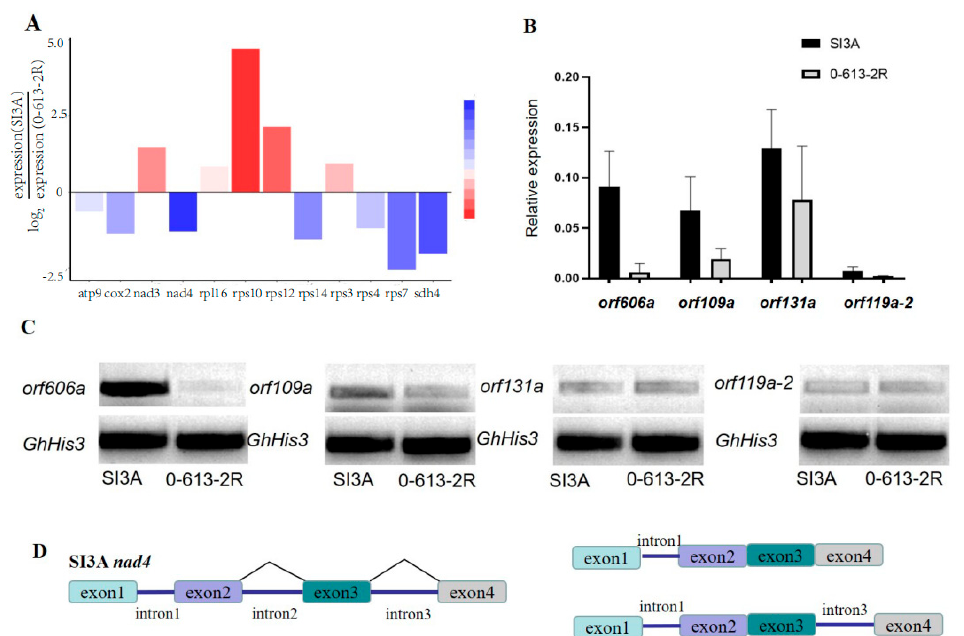
Figure 6. Different expression levels of mitochondrial genes and schematic diagram of nad4 intron splicing patterns. ( A ) Relative expression levels of mitochondrial genes with significant differences in RNA − seq data. Blue represents significantly downregulated genes and red represents significantly upregulated genes in SI3A. ( B ) RT − qPCR analysis of four specific ORFs expression in CMS line SI3A and restorer line 0-613-2R, GhHis3 was used as the internal control. ( C ) RT − PCR analysis of the four specific ORFs in 0-613-2R and SI3A. ( D ) Schematic diagram of nad4 intron splicing patterns, two transcripts formed after splicing retention of intron 1 and intron 3 are shown on the right.